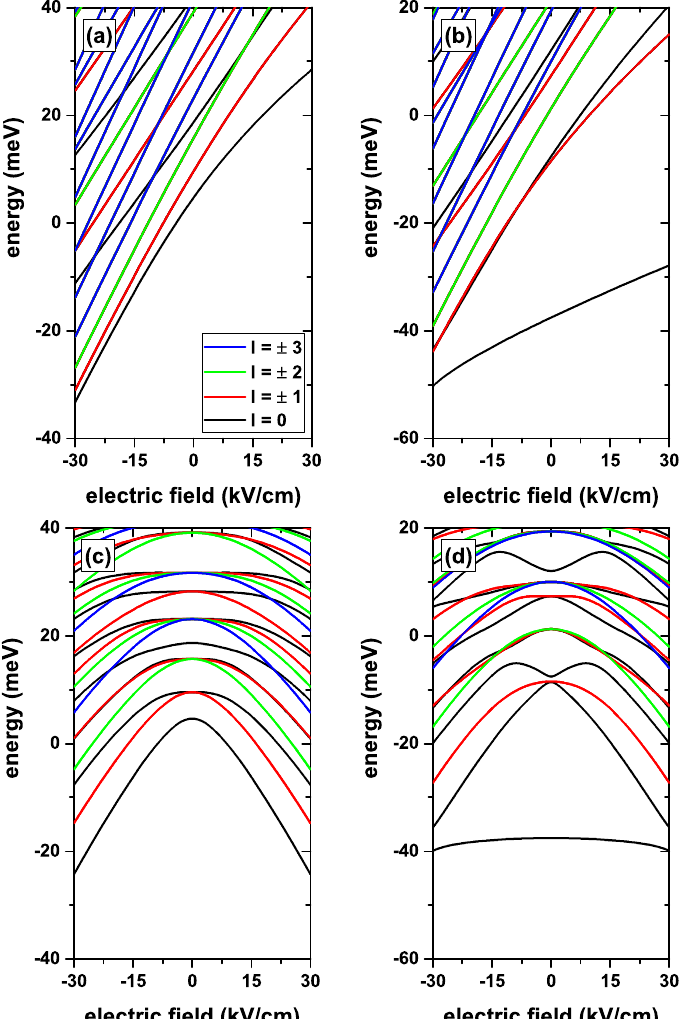
Figure 3. (color online) The lowest confined electron states in a CdS/ZnS spherical QD as functions of the central ( a , b ) and z -directed ( c , d ) EFs. Results are without ( a , c ) and with ( b , d ) on-center donor impurity, with R 1 = 20nm and R 2 = 30nm, for several values of the l -quantum number and without MF